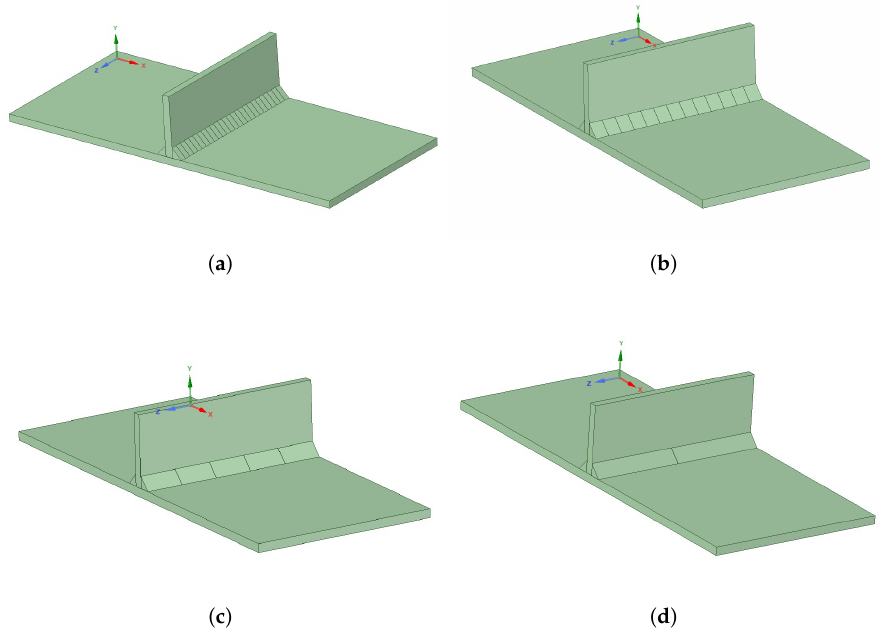
Figure 5. Analyzed geometries: ( a ) 52 divisions, ( b ) 26 divisions, ( c ) 10 divisions, and ( d ) 4 divisions. This geometry was used with S355, S700, and S960 steel to model the case defined by Bhatti et al. [25].